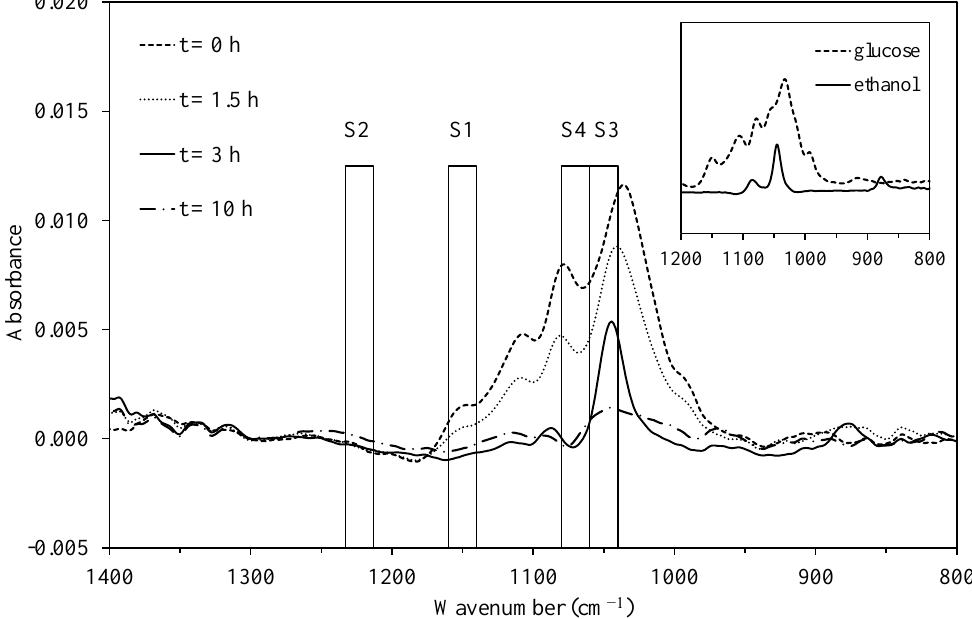
Figure 2. FT-MIR-ATR spectra obtained during yeast fermentation and selected spectral regions (S1–S4) used for the MLR models. The spectra were corrected against the culture medium and inoculum without the initial carbon source glucose and offset-corrected by subtraction of a straight line. Top right: FT-MIR-ATR spectra of 30 g L − 1 glucose and 10 g L − 1 ethanol in deionized water for comparison (background against deionized water).